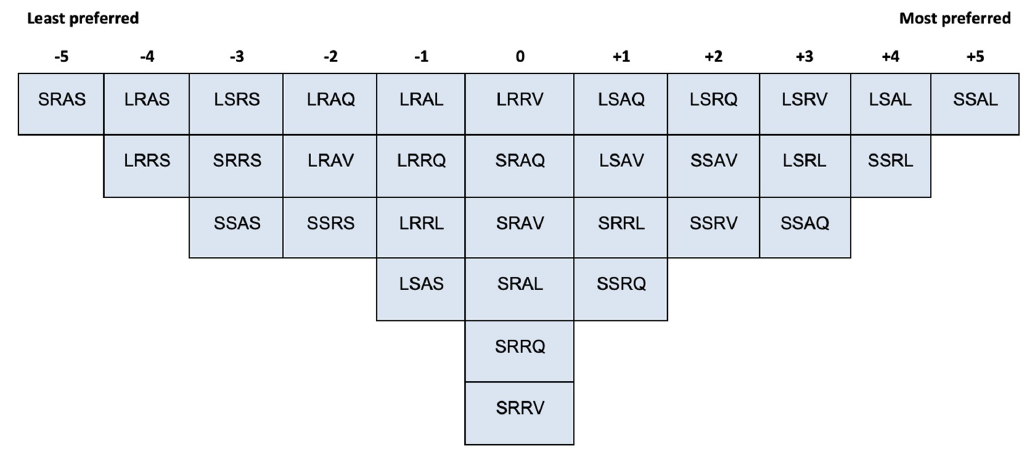
Figure 7. The shared Q-sorting result of participants loaded on Q-factor 1. Vision 2020 , 4 , x FOR PEER REVIEW